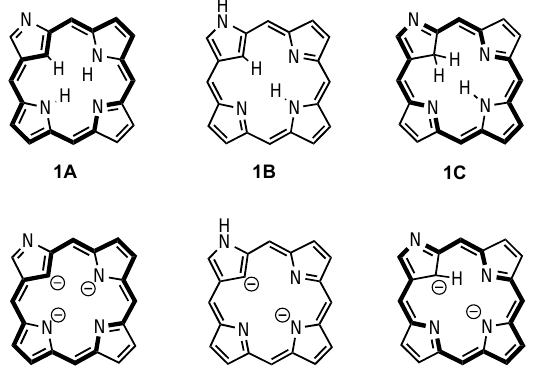
Figure 2. Three tautomers of N-confused porphyrin and formal representations of the corresponding di- and trianionic ligands.